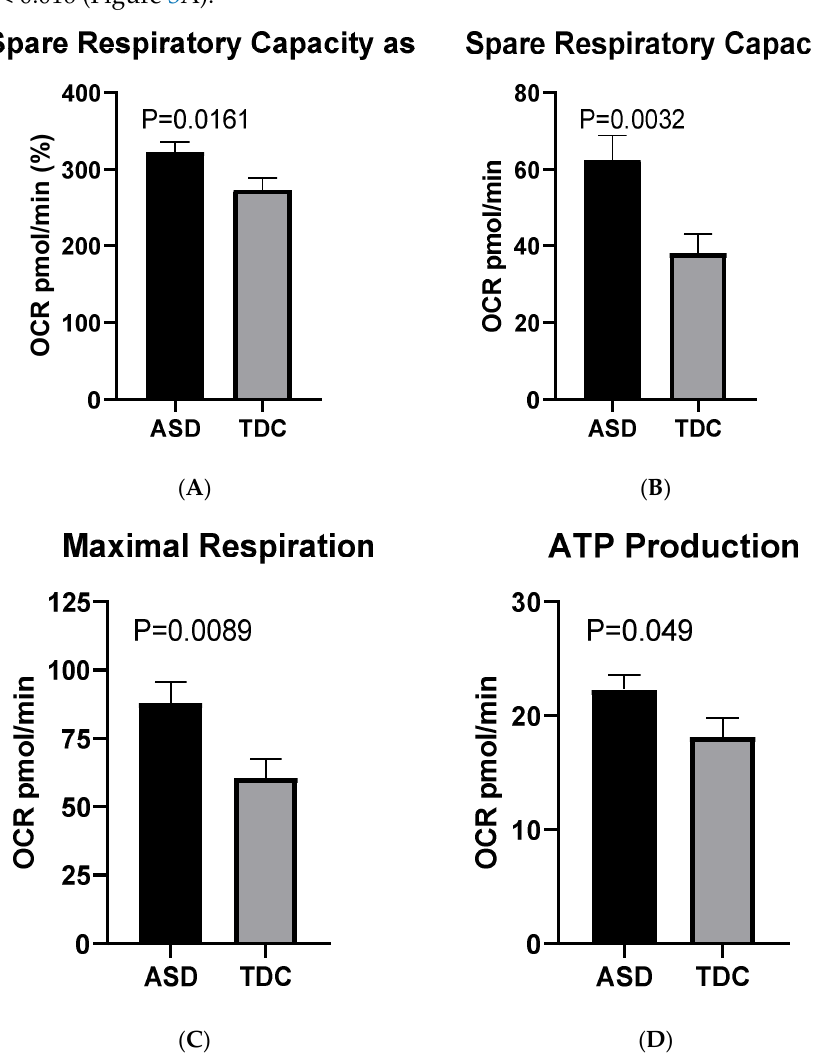
Figure 3. Basic respiratory parameters in ASD ( n = 40) and TDC ( n = 12): ( A ) spare respiratory ca- pacity as %; ( B ) spare respiratory capacity as absolute values; ( C ) maximal respiration; ( D ) ATP production.